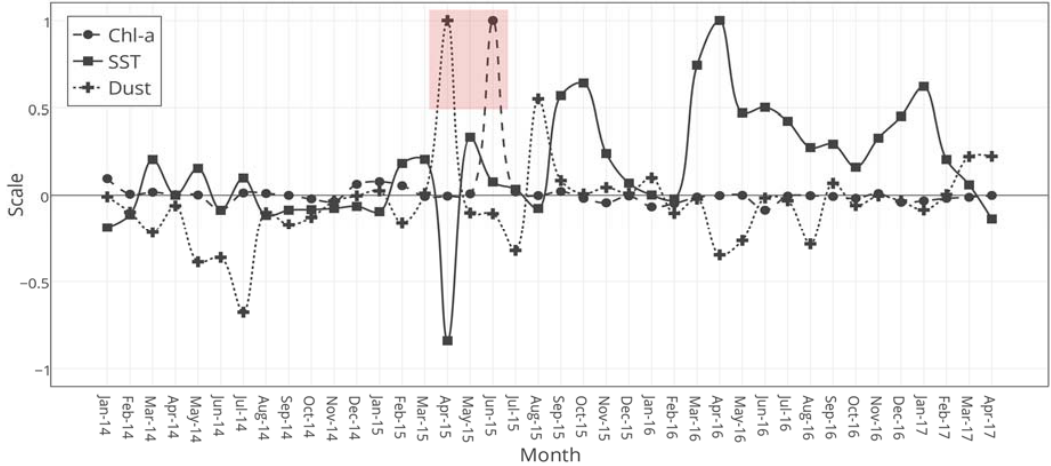
Figure 8. Time series of scaled anomalies for the SCRS for Chl- a and SST from MODIS-Aqua and dust aerosol optical depth (DAOD) from MERRA-2. The red box indicates the period from April to June 2015 including the largest anomalies in both DAOD and Chl- a .